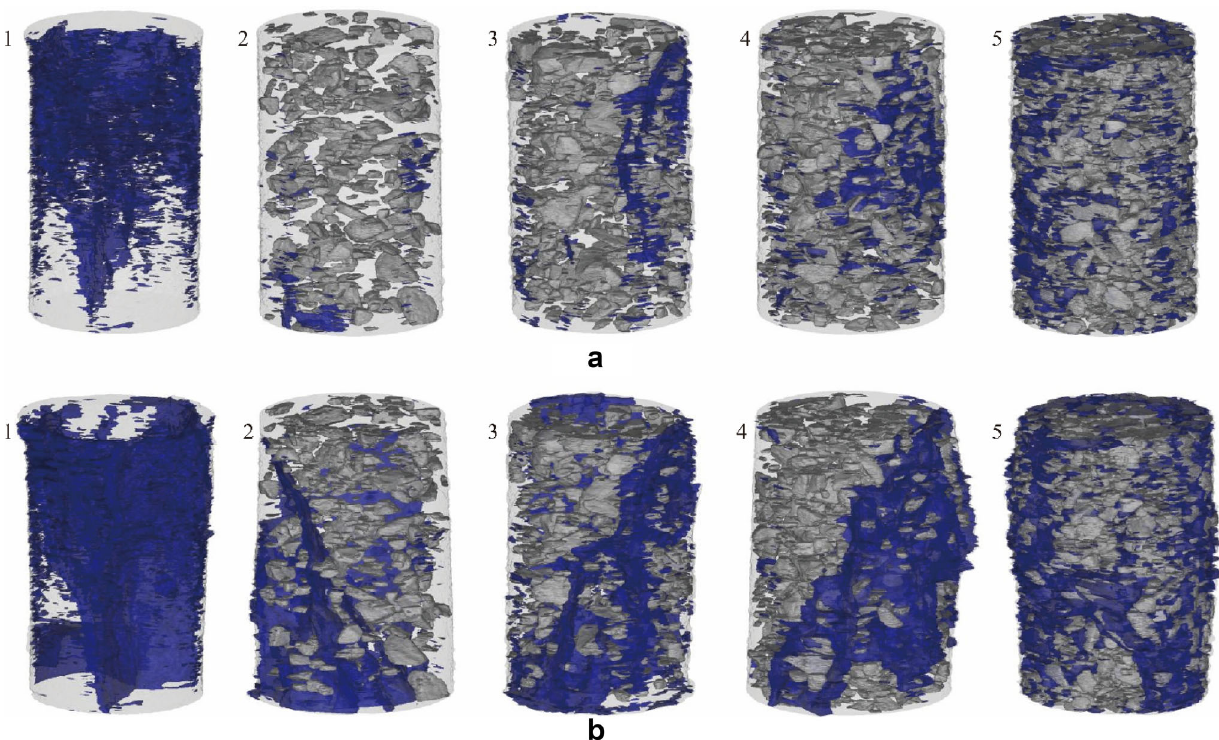
Fig. 17 CT images of 3D crack distribution and growth in SRM (Blue, dark gray and transparent light gray represent the crack, rock and soil, respectively. Rows a and b show the crack distribution and growth when the applied load reached the levels of peak load and 40% post-peak